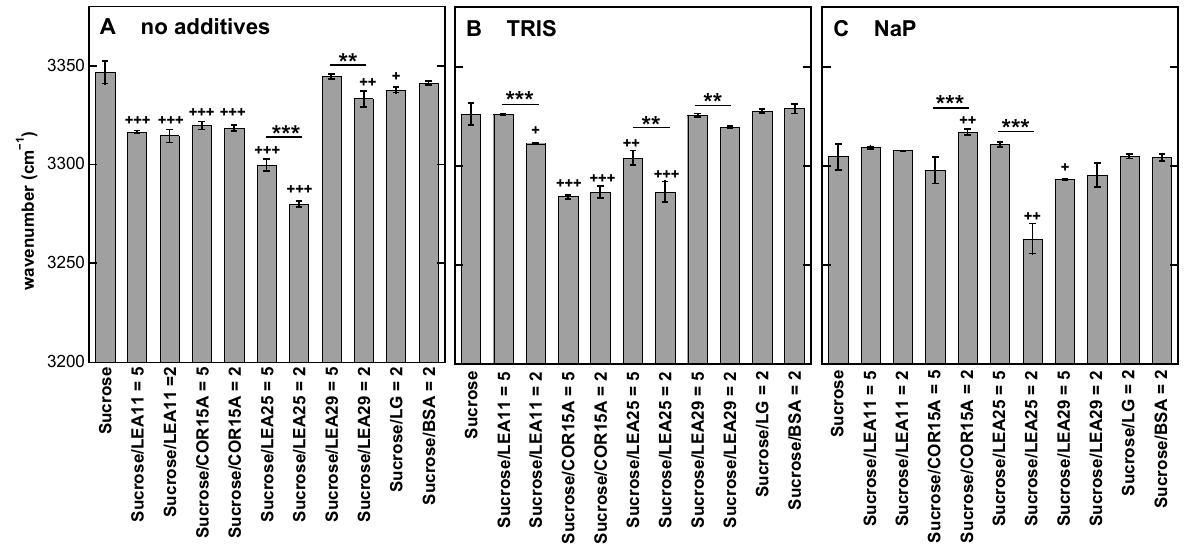
Figure 3. Position of the ν OH peak of dry Suc in the glassy state at 30 °C. Samples contained either pure Suc or, in addition, the proteins LEA11, COR15A, LEA25, LEA29, β -lactoglobulin (LG) or bovine serum albumin (BSA). All solutions contained 10 mg/mL Suc and were prepared in H 2 O ( A ), 10 mM Tris ( B ) or 10 mM NaP buffer (pH 7.4) ( C ). In addition, samples contained proteins at the indicated Suc/protein mass ratios. Samples were dried on CaF 2 windows. The bars indicate the means from at least three samples ± standard deviation. Statistically significant differences between the values determined at the two different Suc/LEA mass ratios are indicated by *, while significant differences between the values obtained in the presence of the different proteins and pure Suc are indicated by + ( + <0.05; **, ++ ˂ 0.01, ***, +++ ˂ 0.001).